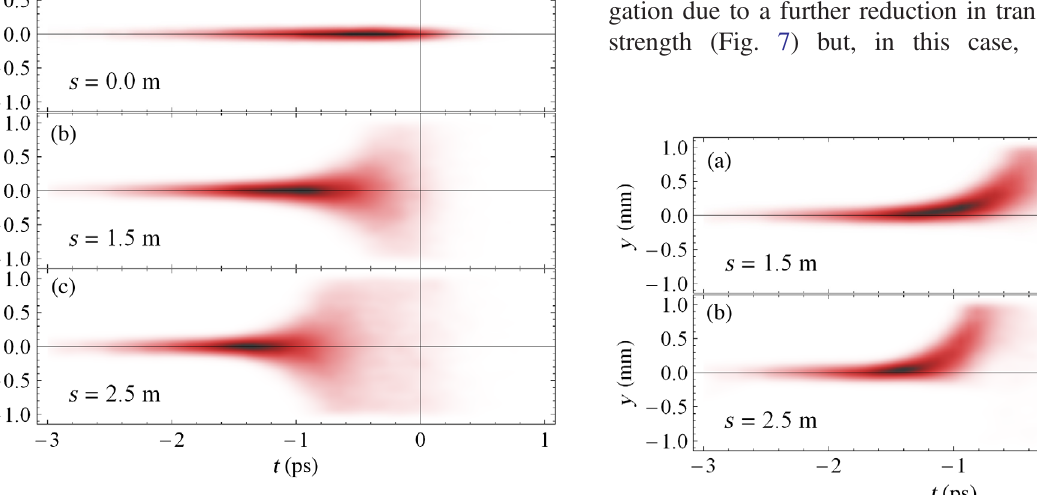
FIG. 14. Transverse-longitudinal distribution of particles after 1.5 and 2.5 m propagation distance through the structure. The beam is initially offset vertically by y 0 ¼ 50 μ m. F x is